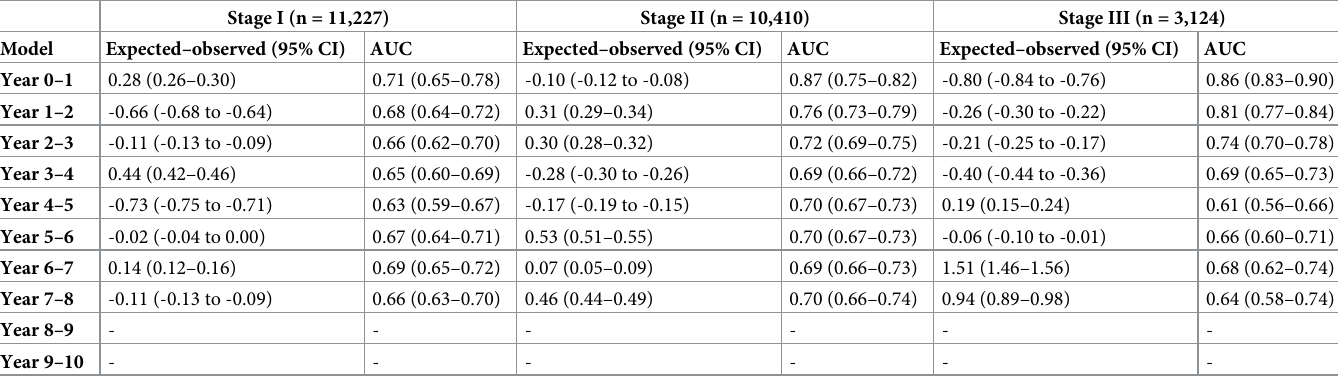
Table 3. Calibration and discrimination of the model on the external validation population (2007–2008, n =